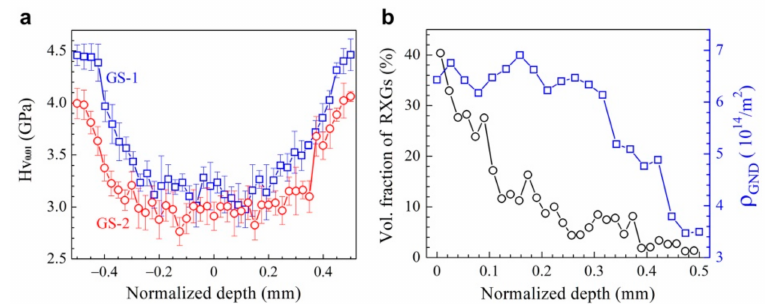
Figure 2. ( a ) The micro-hardness distributions along the depth for the GS1 and GS2 samples. ( b ) The relative area ratio of RXGs (UFGs) and the average GND density ( ρ GND ) as a function of normalized depth for the GS2